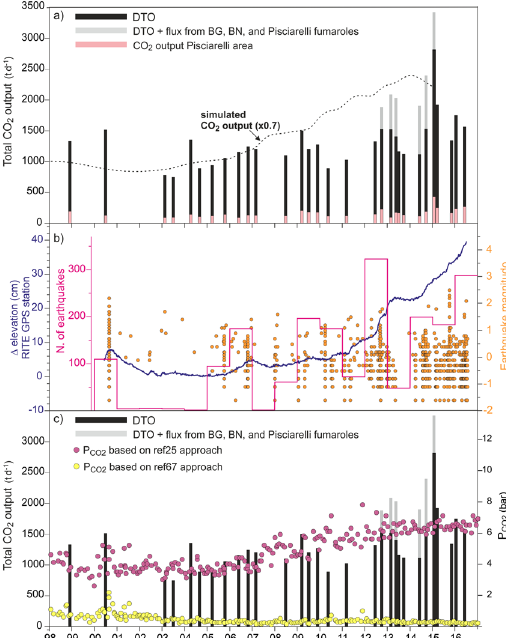
Figure 7. ( a ) Chronogram of the measured CO 2 release at Solfatara compared with the CO 2 output resulting from the physical-numerical simulation of ref. 3. Measured CO 2 flux from the main fumaroles, available since October 2012 and performed in periods not too different from those of CO 2 flux survey 12, 31, 32, 65 , is reported together with the estimated CO 2 release by diffuse degassing. The diffuse degassing computed for the Pisciarelli area (area PIS in Fig. 1) is also reported. The CO 2 output simulated by the physical-numerical simulation is reported with a 0.7 scaling factor. ( b ) Earthquake magnitudes, number of earthquakes and ground elevation at RITE GPS station are reported for comparison 4, 54 (2016 data update from http://www.ov.ingv.it/ov/it/banche- dati.html). ( c ) Comparison of total CO 2 output with the P CO2 estimations based on two recently published alternative approaches to gas equilibria 25, 67 (see the text for